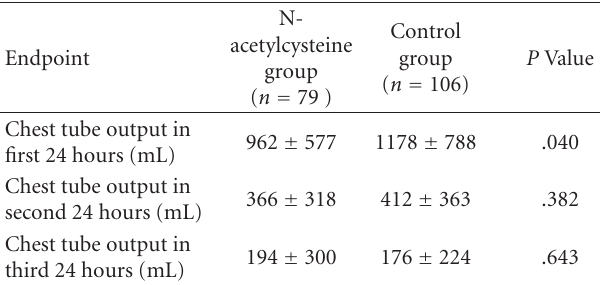
Table 3: Primary Endpoints.